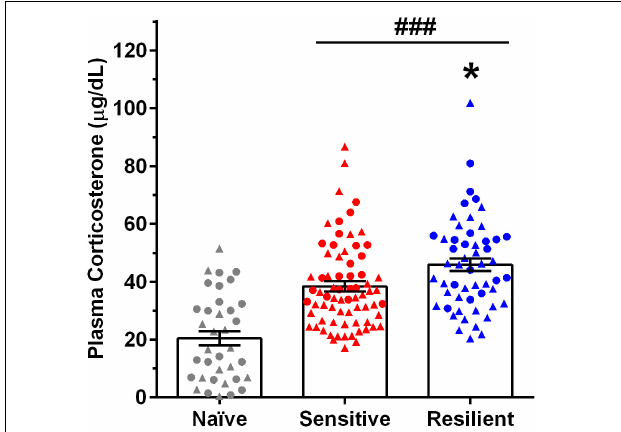
FIGURE 4 | Predator stress (PS) significantly increases plasma corticosterone (CORT) levels, with greater increases in the “resilient” vs. “sensitive” subgroup. Depicted are mean ± SEM plasma CORT levels for male and female mice following exposure to the first and fourth predator stress (PS1 and PS4) vs. values in naïve mice. Individual data points are shown collapsed across sex (males = triangles, females = circles) and PS. Group size: naïve (15 male, 21 female), “sensitive” subgroup (25 male, 11 female per PS), “resilient” subgroup (17 males, 10 females per PS). Plasma CORT levels increased significantly over naïve values following PS, and they were significantly higher in the “resilient” ( ↑ 124%) subgroup vs. values in the “sensitive” ( ↑ 88%) subgroup. * p < 0.05 vs. “sensitive” subgroup; ### p < 0.001 vs. naïve.